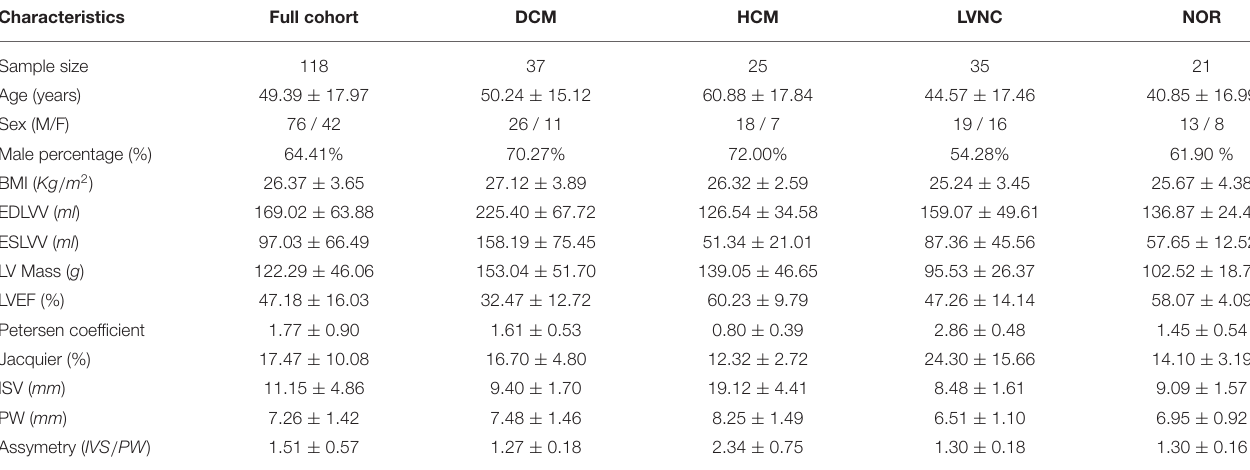
TABLE 2 | Cohort characteristics.